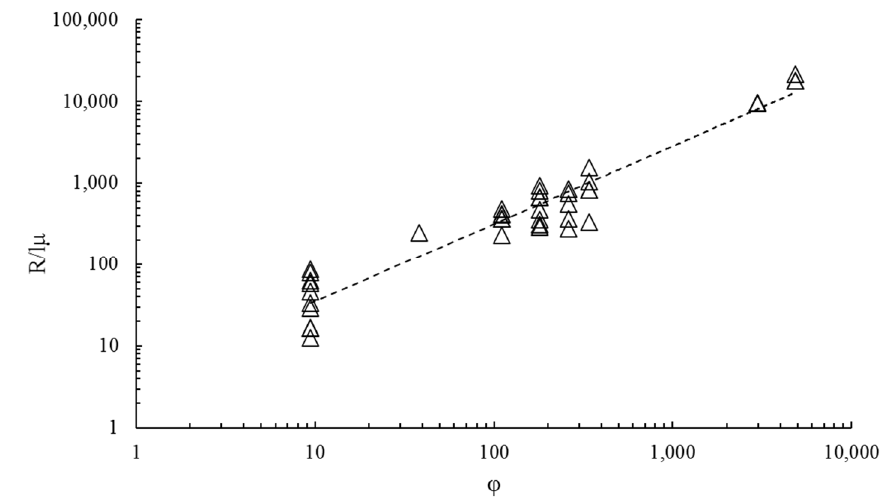
Figure 9. Dimensionless satellite droplet radius R / l µ as a function of ϕ with the power law fit R / l µ ~ ϕ 1.0 for multiple solutions of glycerol volume percentages ranging from 0 to 55%.